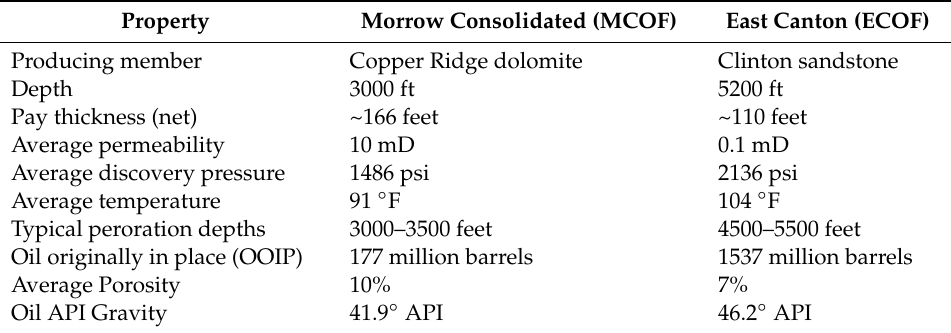
Table 1. Morrow Consolidated and East Canton Oilfield properties (after Hawkins et